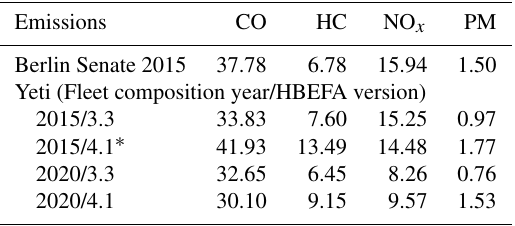
Table 5. Percentages of seasonal day types for 2015 (W: workdays, F: Fridays, S: Saturdays, N: Sundays and holidays) used for the calculation of annual aggregate emission outputs.